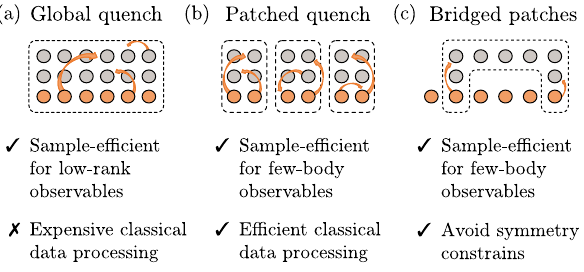
FIG. 4. Different quench setups featuring different interactivity between the system and ancillas, which change the sample complexity of observables. Orange circles denote sites of system of interest while gray circles denote ancillary sites, and only particles within the same dashed boxes are assumed to interact during the quench. The global quench (a) yields a low sample complexity for global, low-rank observables, whereas the patched quench (b) is sample efficient for few-body (i.e., local) observ- ables. The bridged setup (c) is a modification to the patched quench to circumvent symmetry constraints that may be present in the natural dynamics of the extended system, e.g., each patch conserving their individual particle